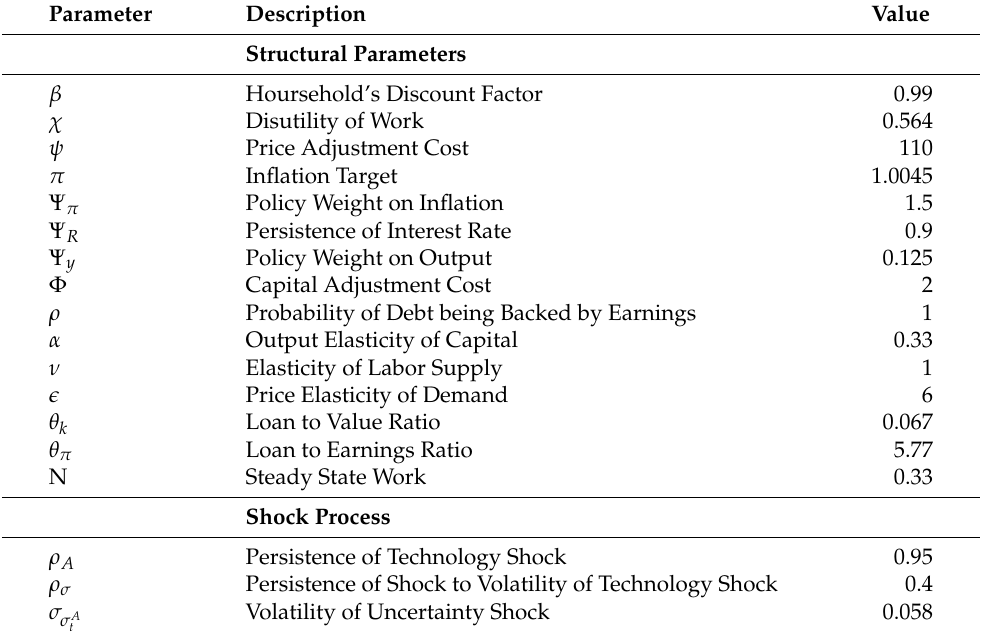
Table 2. Summary of Parameters for the Benchmark Analysis in the DSGE